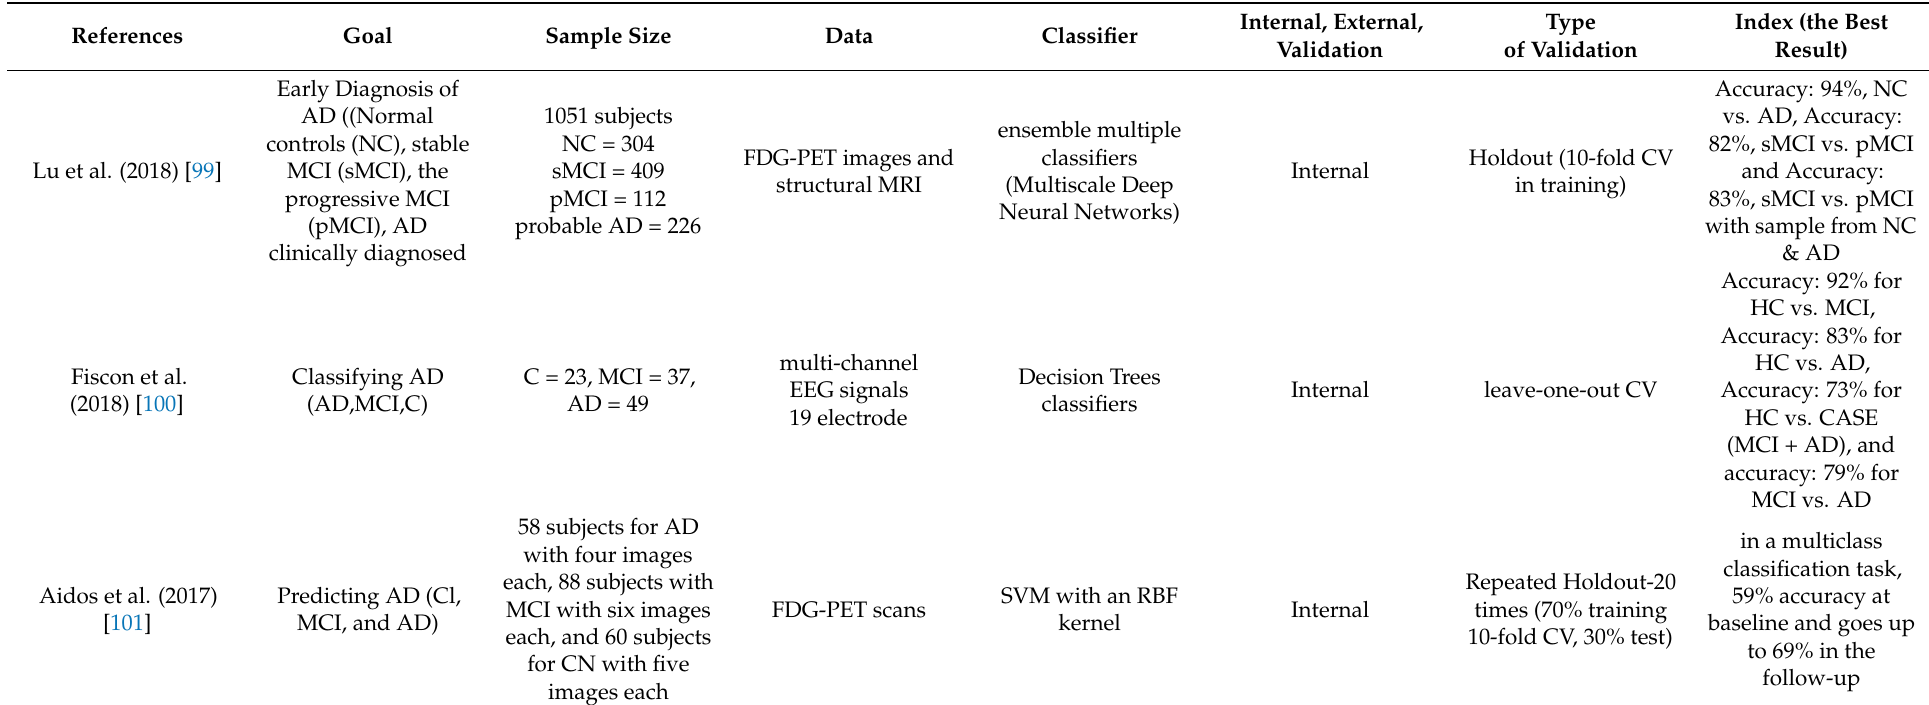
Table 6. CAD methods for mental and neurological disorders